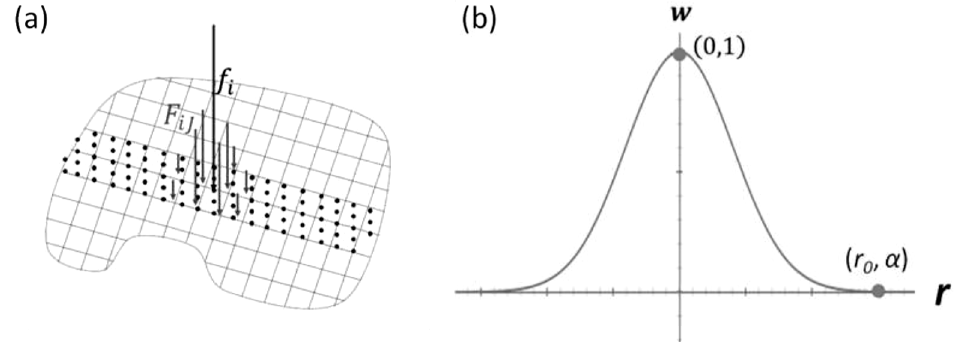
Fig. 4. (a) Nodal force redistribution from ROUVISLAM slipped mesh (black) to ABAQUS mesh (grey). (b) Redistribution function and the involved parameters.